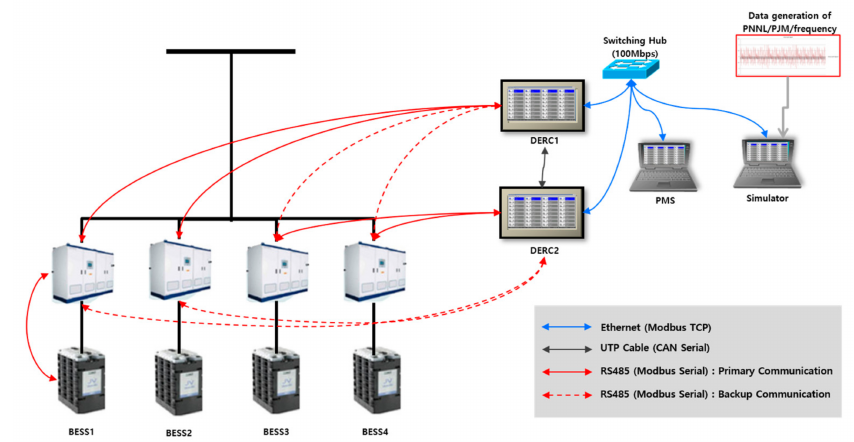
Figure 11. System configuration used for case study.